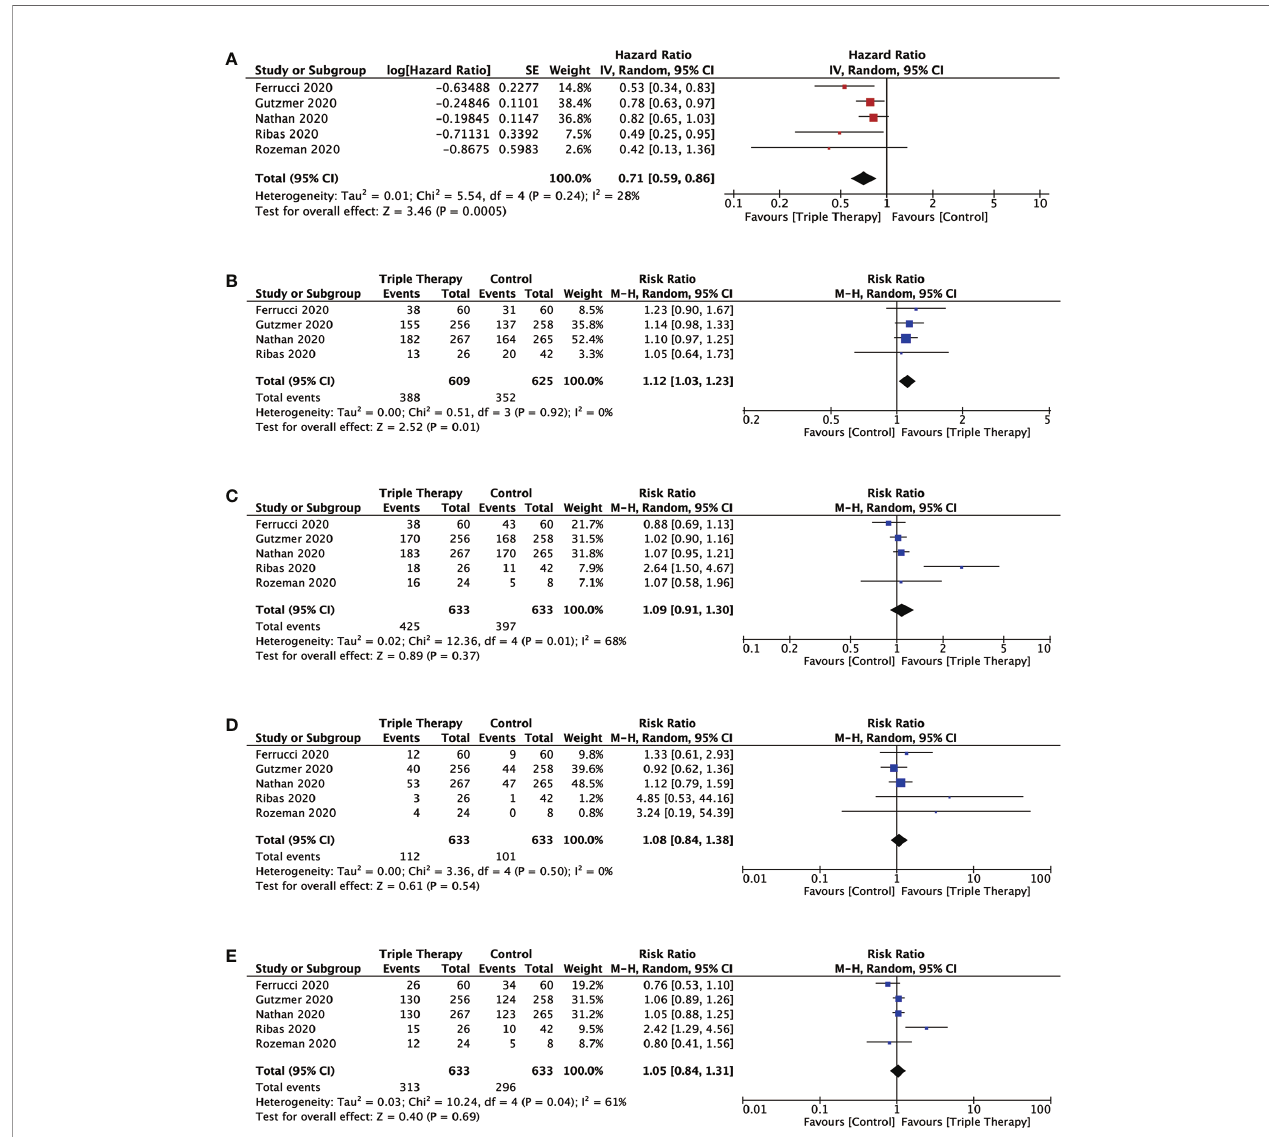
FIGURE 3 | Forest plots analysis of the ef fi ciency outcomes for triple combination therapy of PD-1/PD-L1, BRAF, and MEK inhibition versus control therapy. Pooled hazard ratio (HR) or risk ratio (RR) with 95% CI were determined using the random-effects model for outcomes. (A) PFS (progression-free survival); (B) OS (overall survival); (C) ORR (overall response rate); (D) CR (complete response); (E) PR (partial